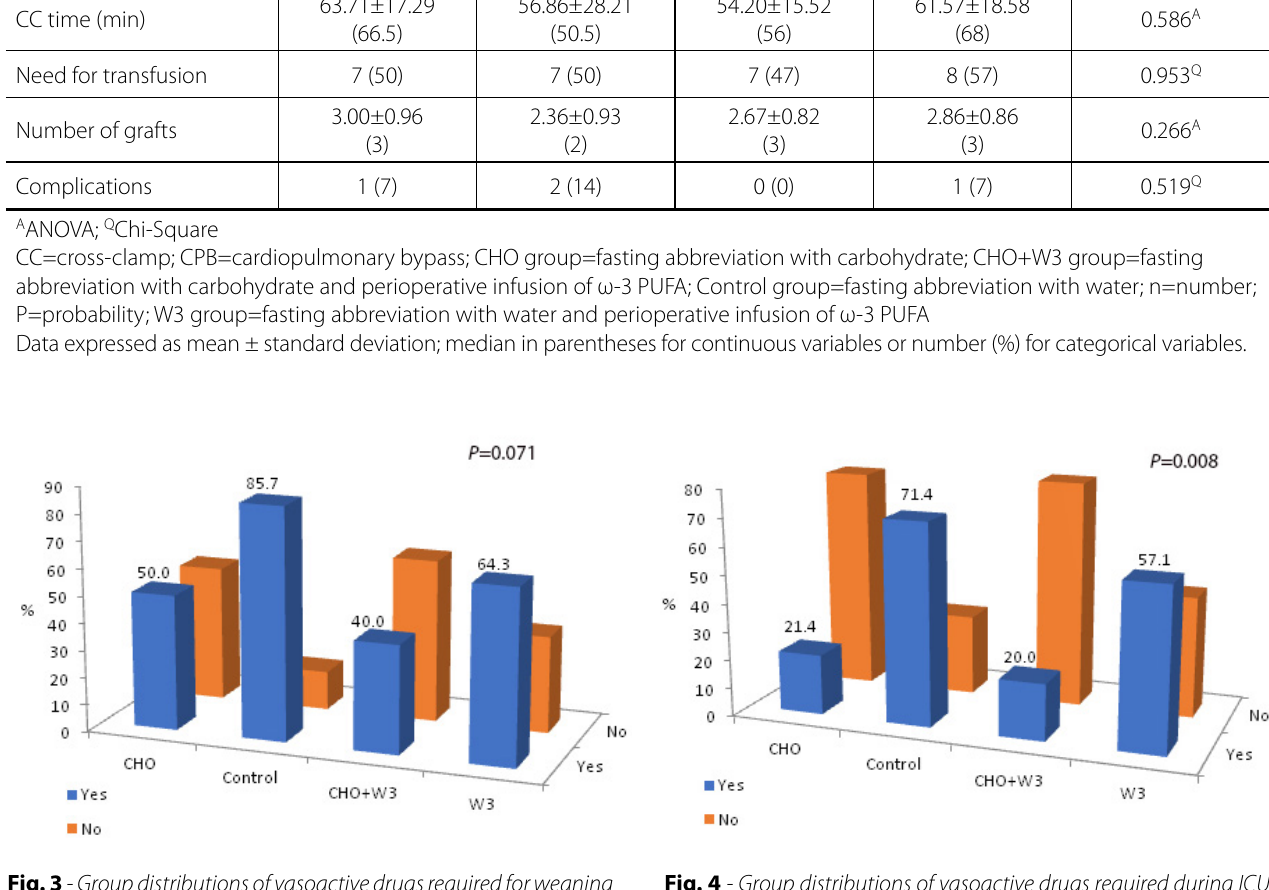
Fig. 3 - Group distributions of vasoactive drugs required for weaning from CPB.